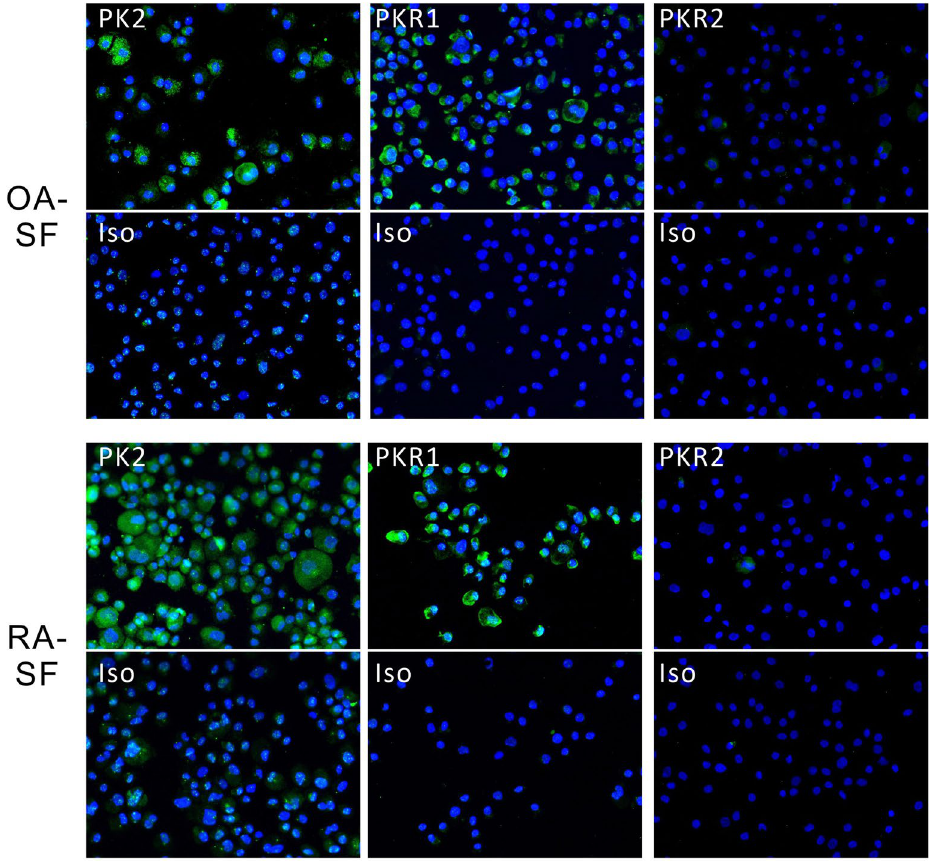
Figure 3. Immunofluorescent staining of PK2, PKR1, and PKR2 proteins in OA- and RA-SF. Cells were subjected to cytospin. Green staining indicates PK2- (left panel), PKR1- (middle panel), or PKR2- (right panel) positive cells (× 200). Stained sections with an isotype control as the primary antibody are also demonstrated. N = 5. PK2 prokineticin 2, PKR1 prokineticin receptor 1, PKR2 prokineticin receptor 2, OA osteoarthritis, RA rheumatoid arthritis, SF synovial